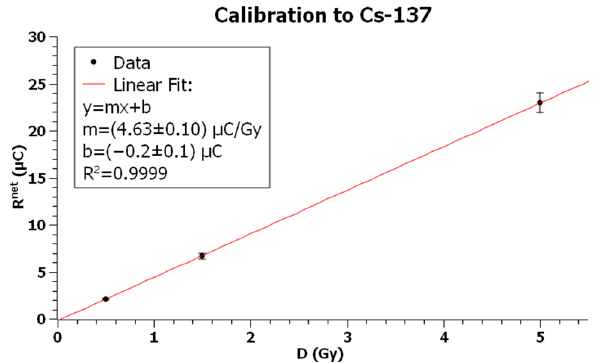
Figure 7. Plot of TLD net readings vs dose for exposures with Cs-137. Error bars represent the expanded uncertainty ( k = 2) for Cs-137 calibration from Table 4.